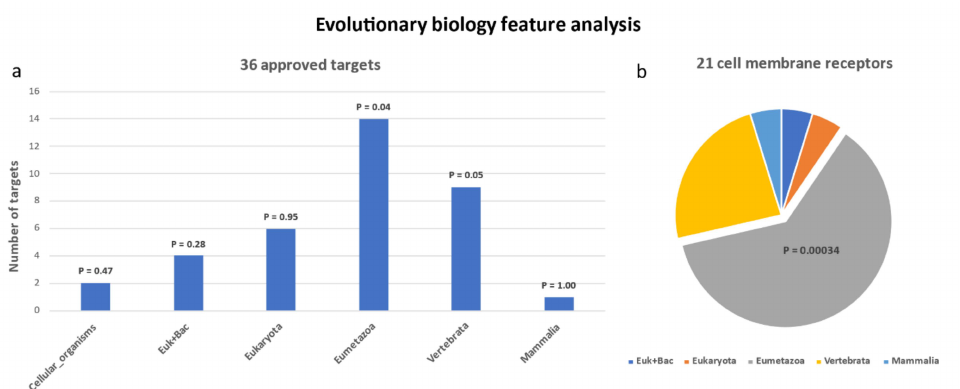
Figure 1. The statistical histogram of evolutionary features of approved antiviral receptors and cell membrane receptors. The results of the evolutionary information statistics showed that the 36 approved targets were distributed mainly in genes belonging to class 6 (Eumetazoa) (14/36, p = 0.04, hypergeometric assay) ( a ). As for the 21 cell membrane receptors, 13 of them were from the Eumetazoan period, and the tendency for enrichment was more pronounced ( p = 0.00034, hypergeometric test) ( b